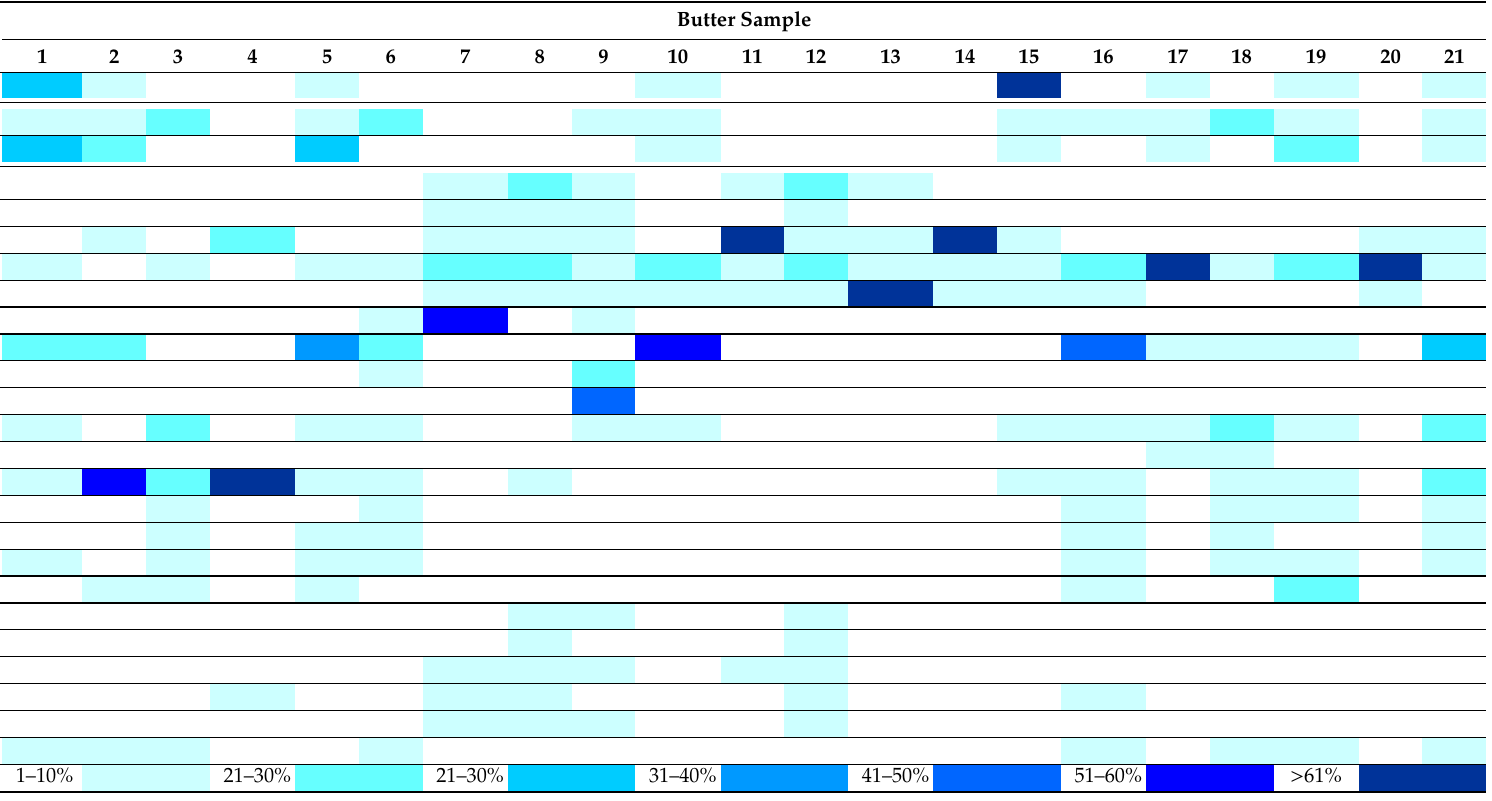
Table 1. The most abundant bacteria in butter